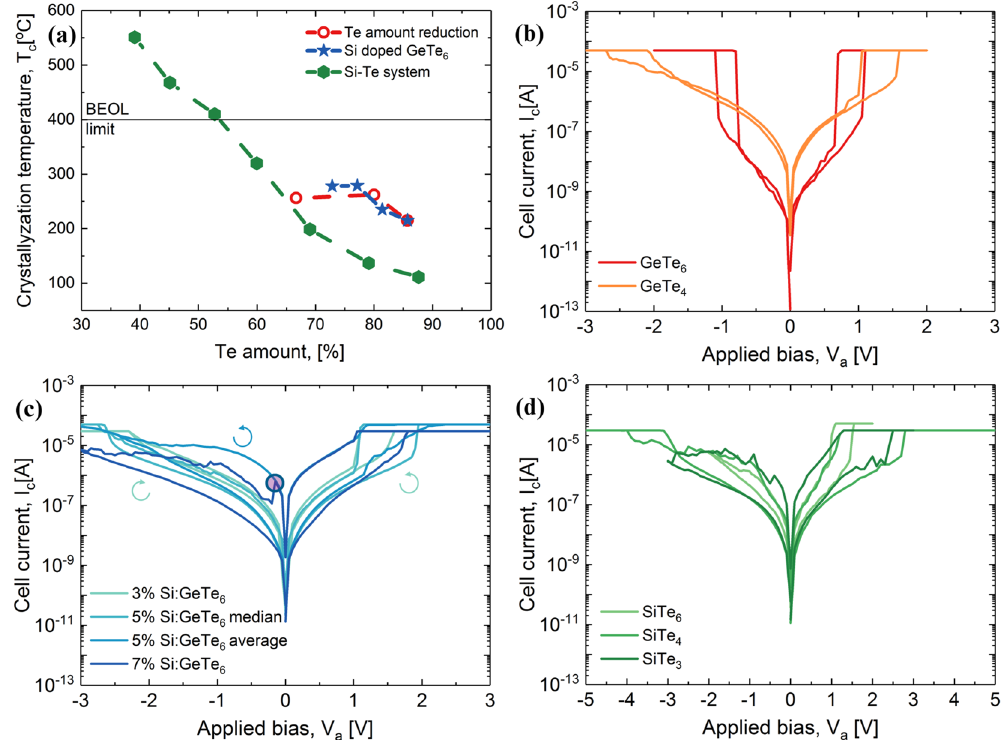
Figure 3. Thermal stability and electrical behaviour for (i) Tellurium amount reduction; (ii) Si doping; and (iii) Replacement of Ge with Si. ( a ): Crystallization temperature variation in all three cases. Typical electrical characteristics of 335 nm devices for ( b ): Ge-Te system; ( c ): Si doped GeTe 6 ; The switching direction (‘set’) is given only for 3%Si:GeTe 6 , the rest of the compositions follow this direction for the positive sweeps, whereas for the negative sweeps at 5%Si: GeTe 6 the direction changes from ‘set’ to ‘reset’; and ( d ): Si-Te system. Each curve from ( b–d ) is the median of 25 sweeps. 30 µ A and 50 µ A compliance currents were